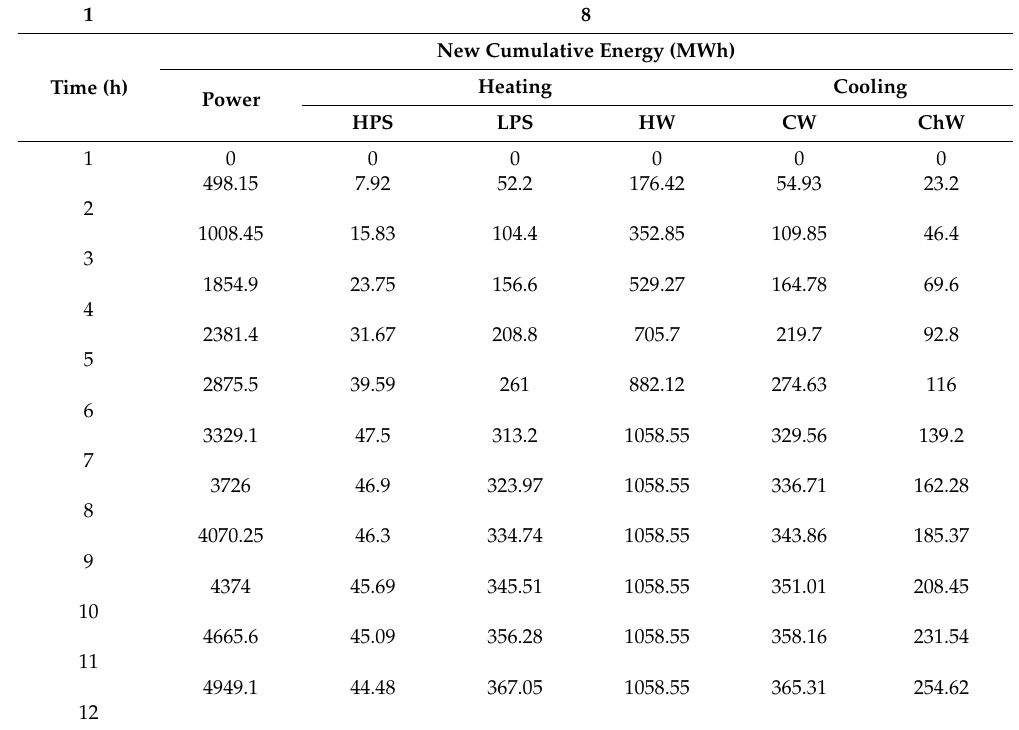
Table A7. TriGenSCA before iteration from 1 to 12